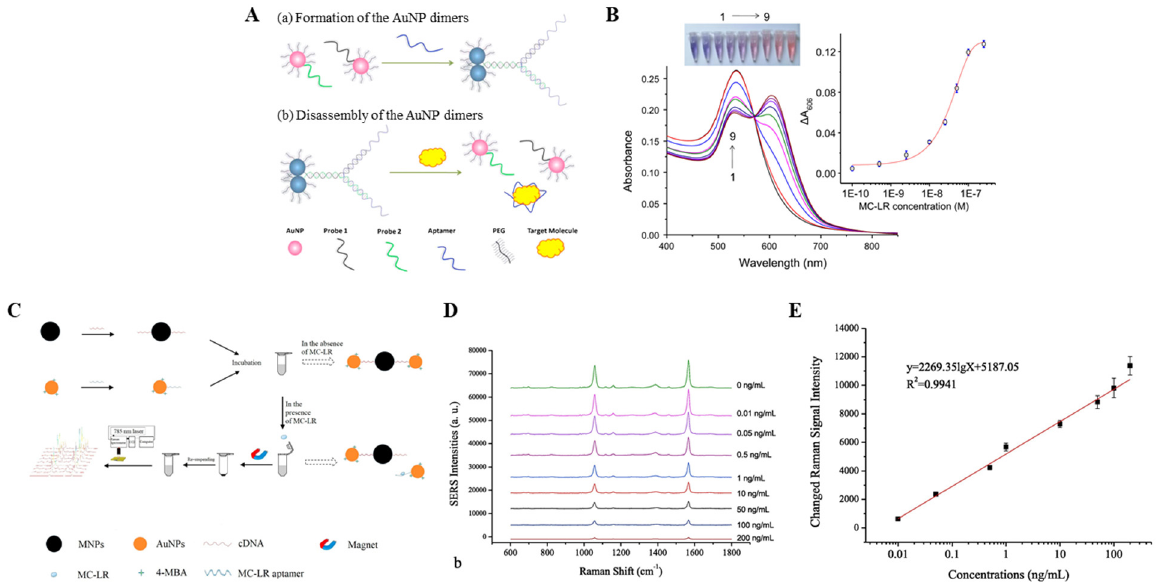
Figure 2. ( A ) Schematic representation of the formation and disassembly of AuNP dimers. ( B ) Extinction spectra of the sensors for different concentrations (0, 0.1, 0.5, 2.5, 10, 25, 50, 100, and 250 nM) of MC-LR. ( C ) Illustration of the principle behind the MC-LR-based analysis on the SERS-based aptasensor. ( D ) Typical SERS spectra with exposure to different concentrations of MC-LR (0–200 ng/mL). (E) Linear correlation between the changed Raman signal intensities and concentrations of MC-LR. Reproduced with permission from [61,68], published by Elsevier, 2015 and 2019, respectively.